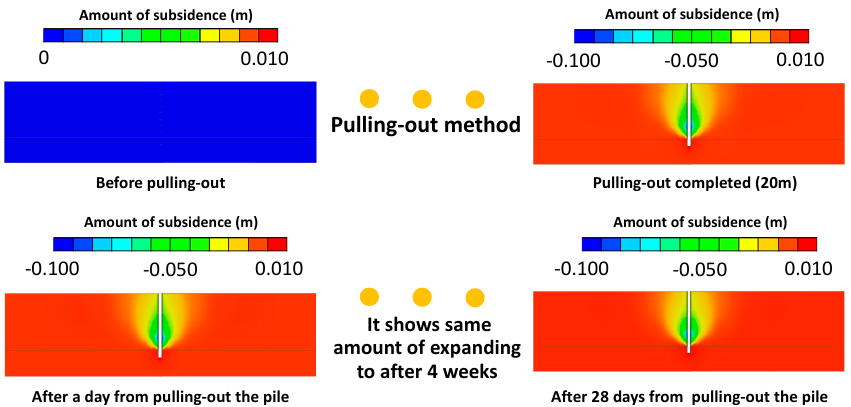
Figure 3. Deformation of the surrounding ground when one extraction hole of a removed pile is hollow.